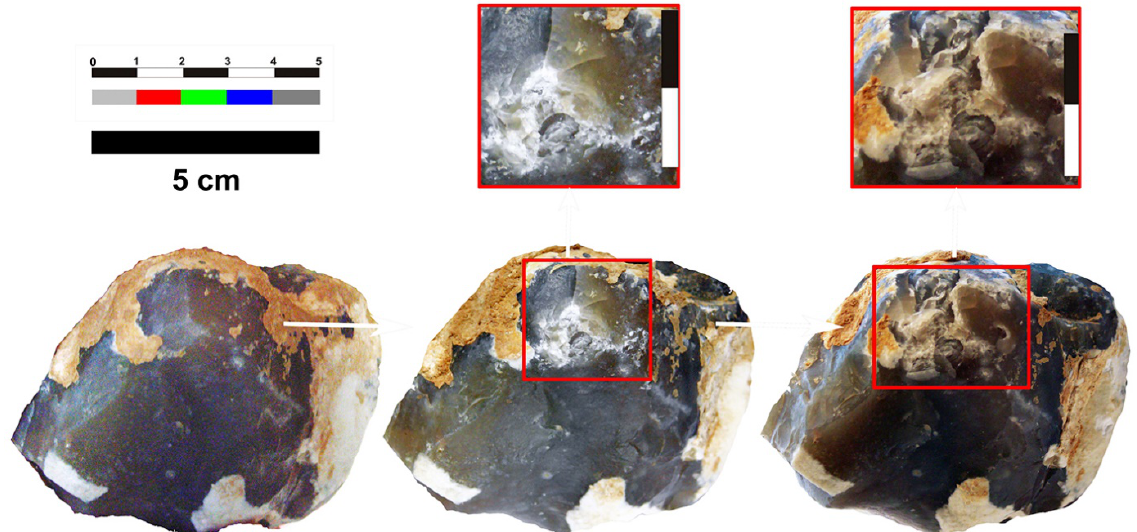
Figure 5. Experimental development of the stigmata on an AZP of a flint